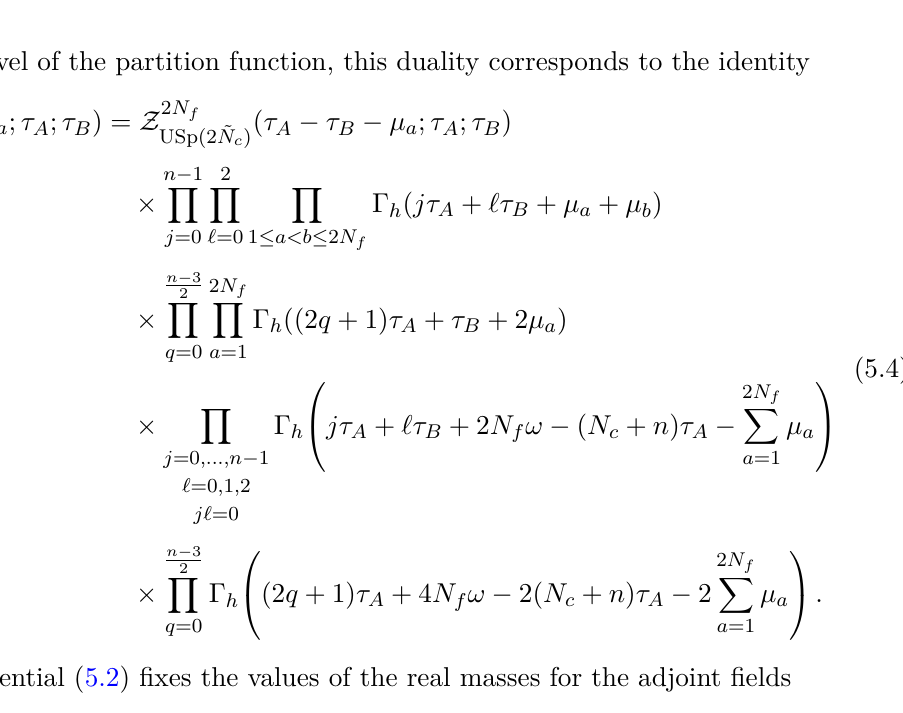
Table 3 . Matter content of USp (2 N c ) 0 and USp (2